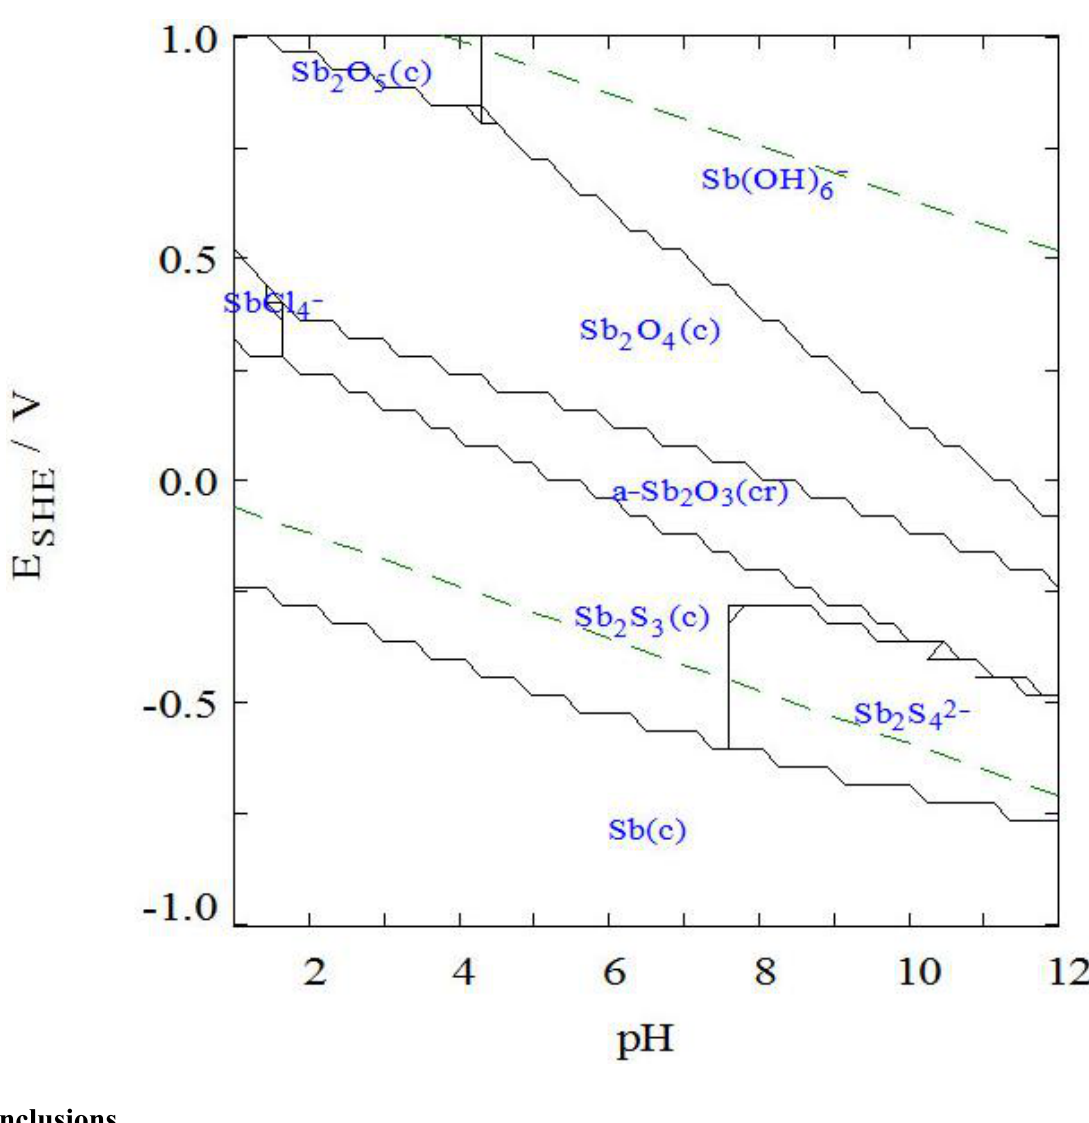
Figure 5. Eh-pH diagram for the system Sb-SO (Puigdomènech 2004). (c): solid phase; E [Sb(OH) ] = 10.00 mM; [SO 42− ] 3 TOT